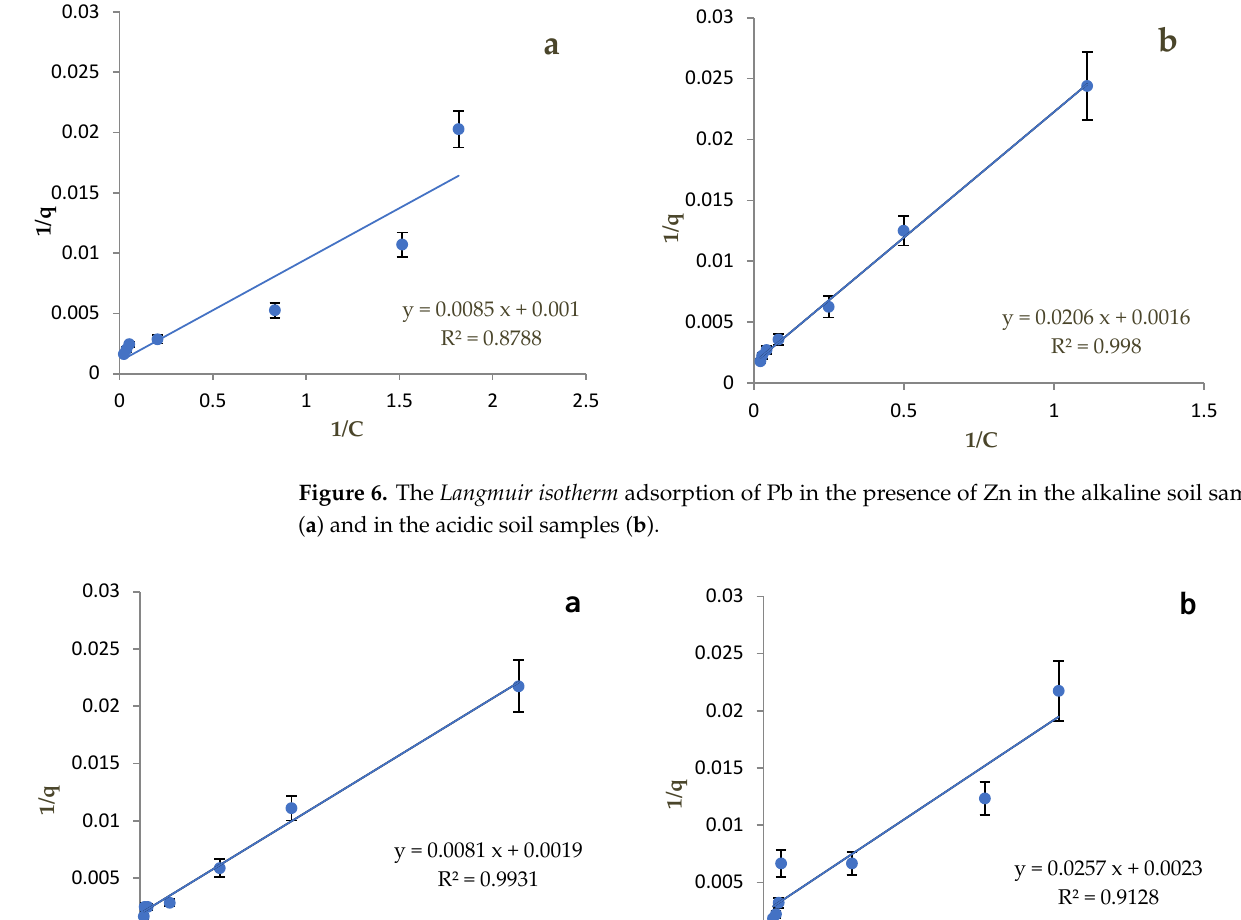
Figure 5. The Langmuir isotherm adsorption of Zn in the presence of Pb in the alkaline soil sample ( a ) and in the acidic soil sample ( b ).